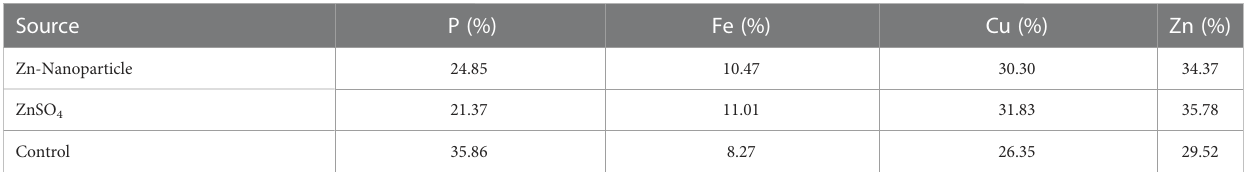
TABLE 3 Comparison of measured elements percentage with control (non-fertilized) in treated D. kotschyi by ZnSO4 and ZnO-N through SEM-EDX method under drought stress.